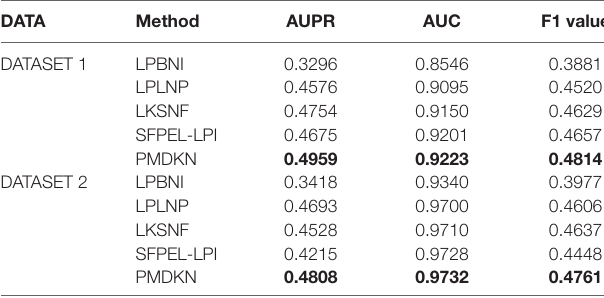
TABLe 1 | Comparison of predicted performance of new lncRNA-protein interactions based on DATASET1 and